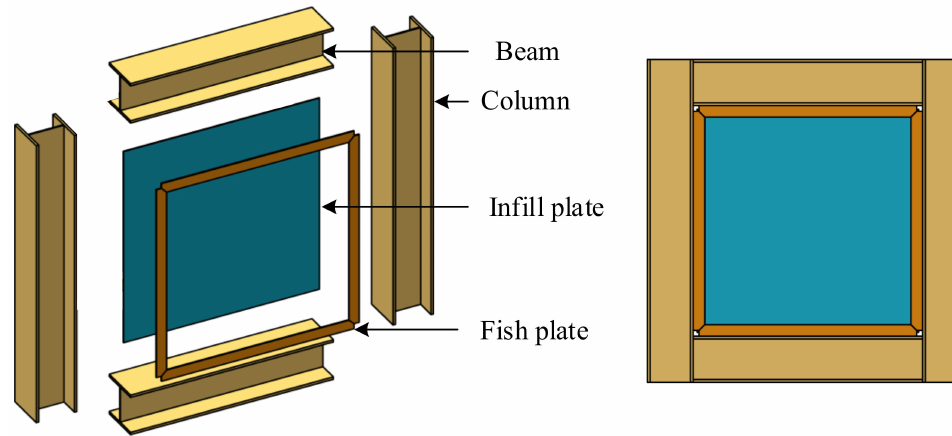
Figure 1. Steel plate shear wall.